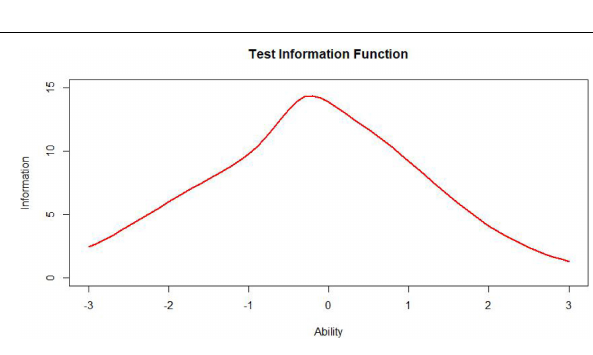
FIGURE 8 | Uniformly distributed test, information, function (TIF).